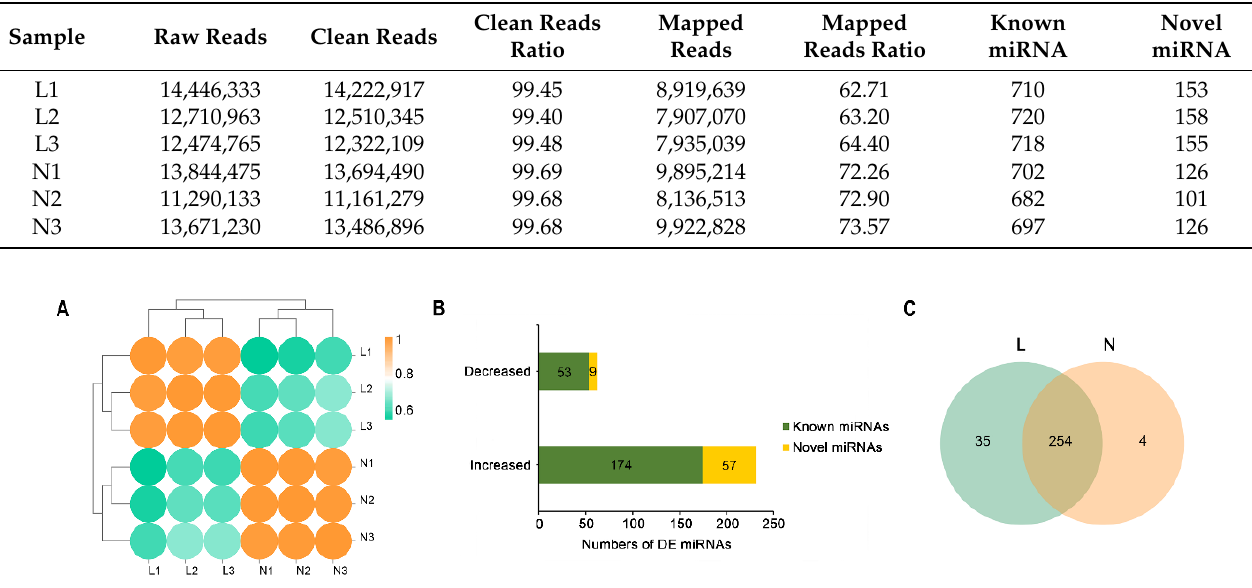
Figure 3. Differential miRNA expression analysis between the L and N groups by miRNA-seq. ( A ) Sample correlation heatmap of miRNAs. ( B ) The histogram shows the number of differentially expressed (DE) miRNAs identified in jenny mammary glands in the L and N groups. ( C ) Venn diagram representation of the common and group-specific DE miRNAs identified in jenny mammary glands of the L and N groups. L, lactating mammary glands of jennies; N, nonlactating mammary glands of jennies.